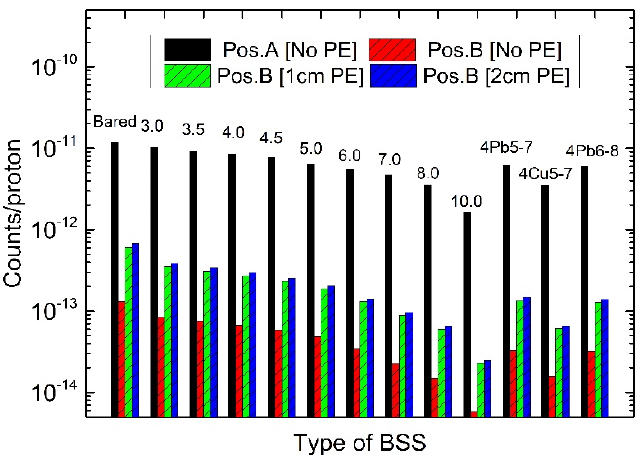
Figure 3. Counting rates of ERBSS at two measurement locations. ERBSS sphere type indicated above bars.